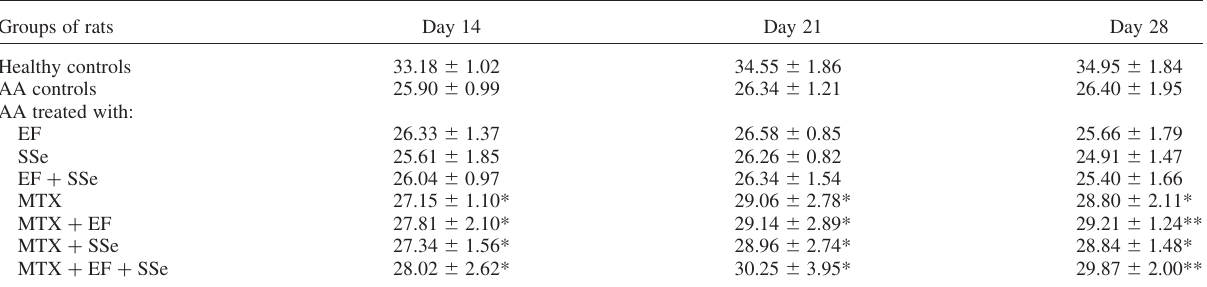
TABLE III The effect of preventive treatment with methotrexate (MTX), E. faecium (EF), selenium (SSe) and their combinations on serum albumin concentrations (g/L) in rats with AA Groups of